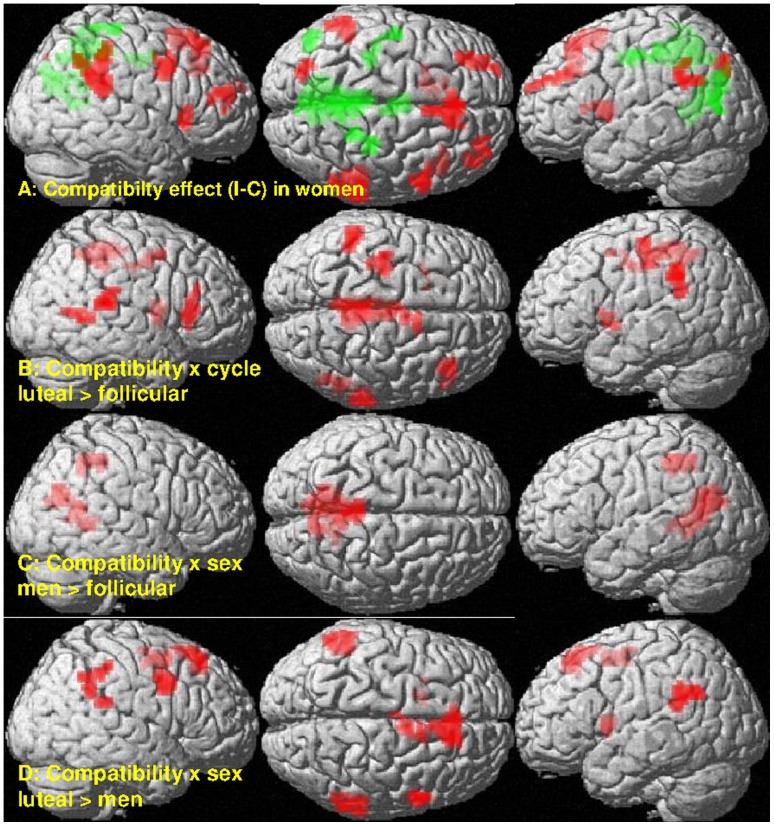
Sex- and menstrual cycle-dependent differences in the BOLD-response compatibility effect.A: Women during follicular phase show higher BOLD-response for compatible compared to incompatible items (negative effect of compatibility) in deactivation areas (green). Thus, deactivation is stronger for incompatible compared to compatible items. Women during luteal phase show higher BOLD-response for incompatible compared to compatible items (positive effect of compatibility) in the frontal cortex (red). Men did not show a significant compatibility effect. B-D: Consequently compatibility x sex/cycle interactions were observed in frontal and deactivation areas (see Table 2 for cluster labelling).